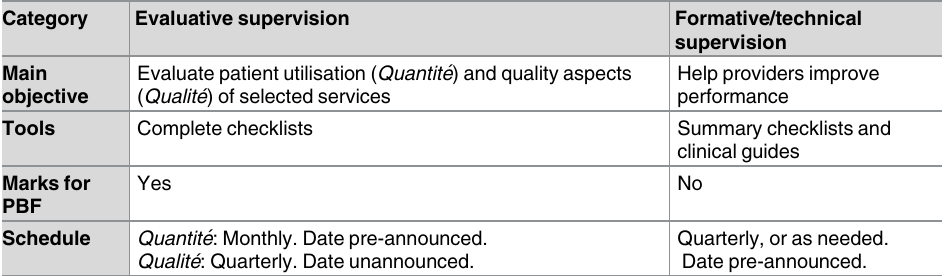
Table 2. Evaluative and formative (technical) supervision of health centres in